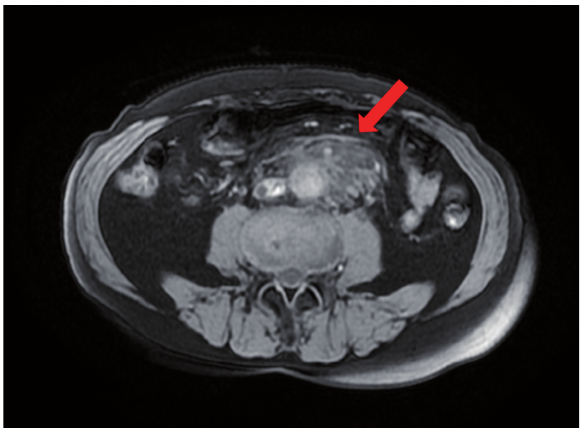
figure 2 - c) Magnetic resonance imaging demonstrated Rpf masses as low and high intensity (according to inflammation) on the